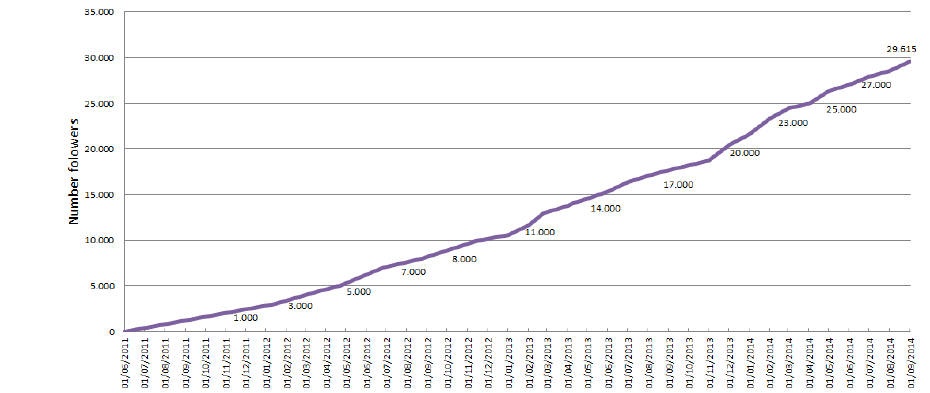
Figure 6. Time evolution of total followers of Euskalmet’s Twitter account.